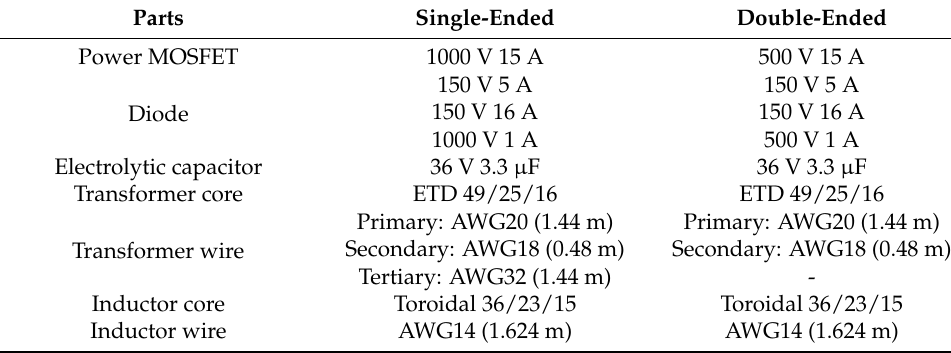
Table 3. Specification of forward converters for